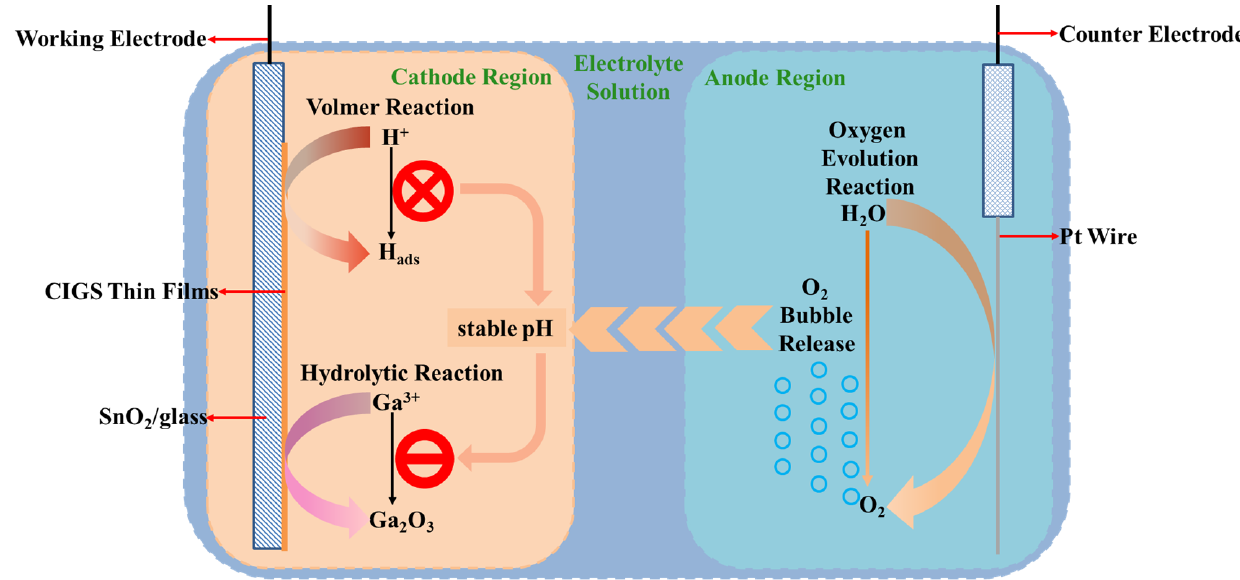
Figure 2. Schematic illustration for the inhibition of Ga 3+ hydrolysis in 3 kPa.